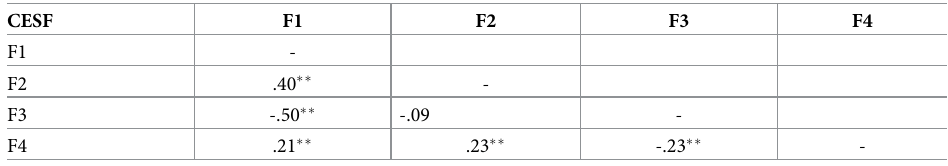
Table 2. Inter-factor